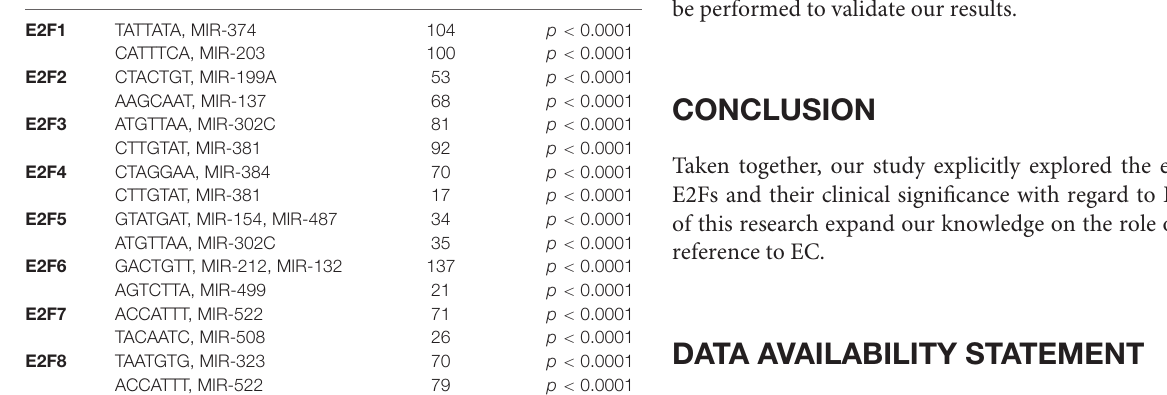
TABLE 2 | The miRNA targets for E2F in UCEC.